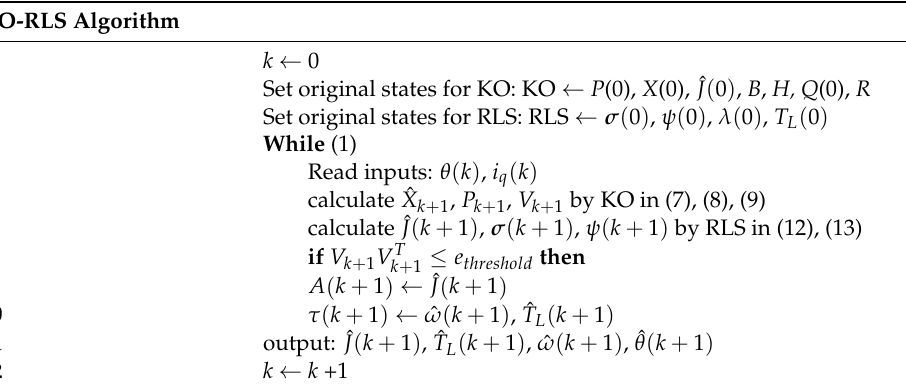
Table 1. The KO-RLS